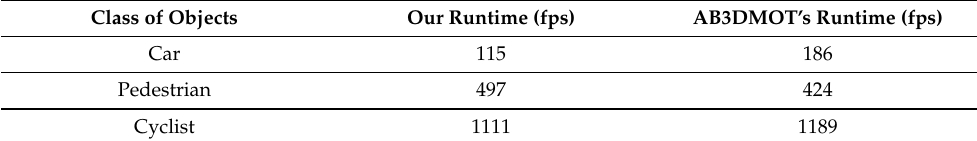
Table 3. Comparison of our approach’s runtime on KITTI dataset against AB3DMOT’s.